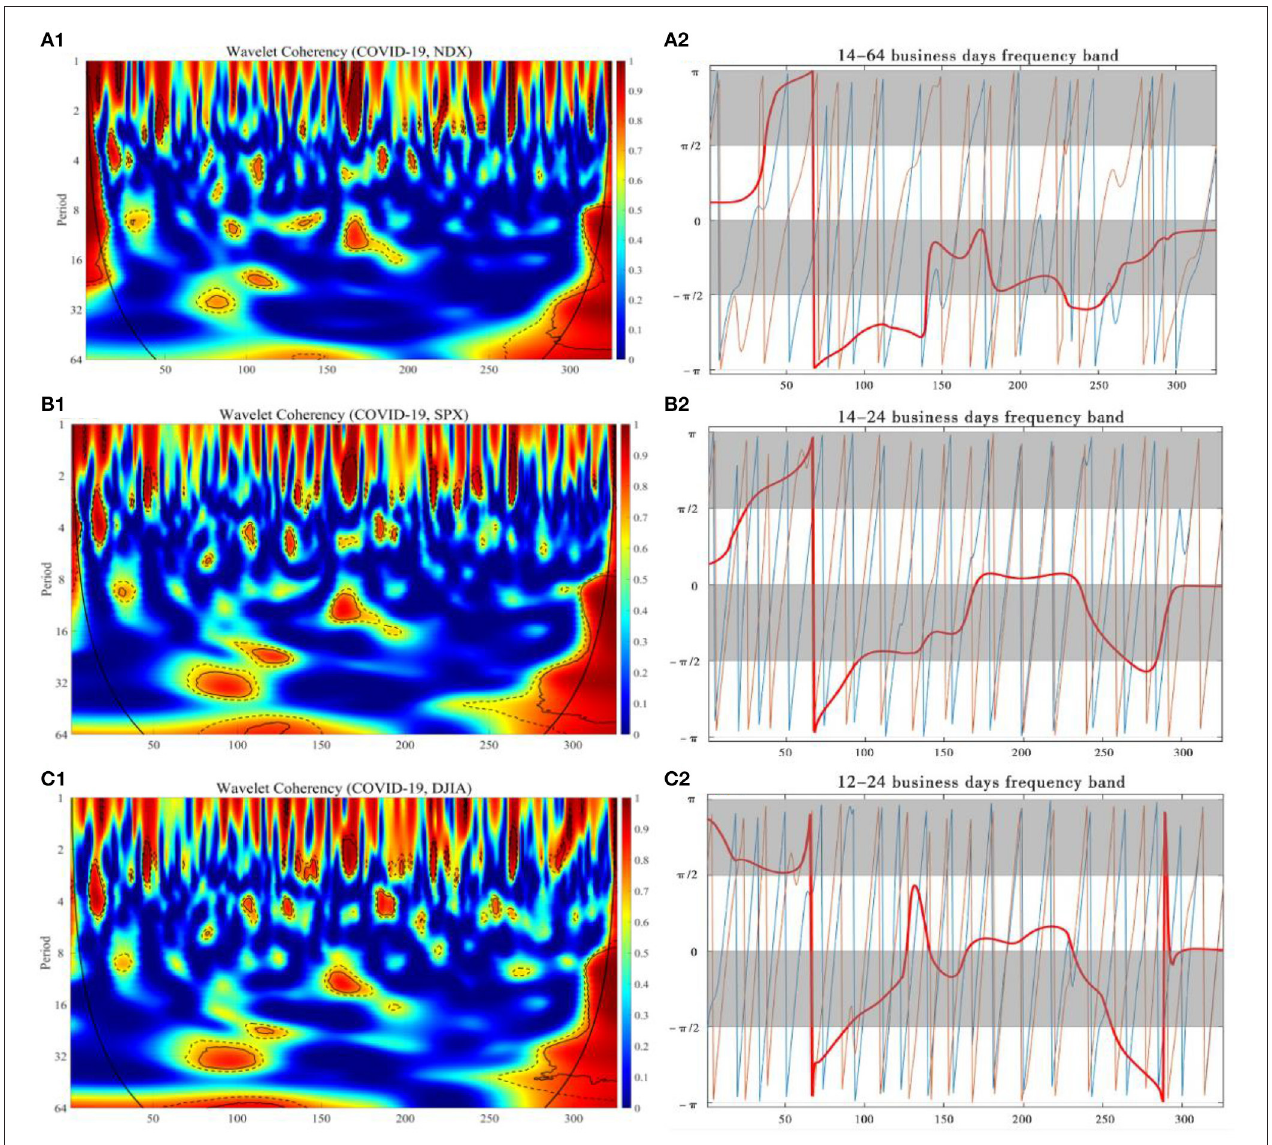
FIGURE 4 | The wavelet coherence and phase difference between daily COVID-19 new cases in U.S. and NDX, SPX, DJIA. Wavelet coherence (A.1, B.1, C.1) and phase difference (A.2, B.2,C.2)